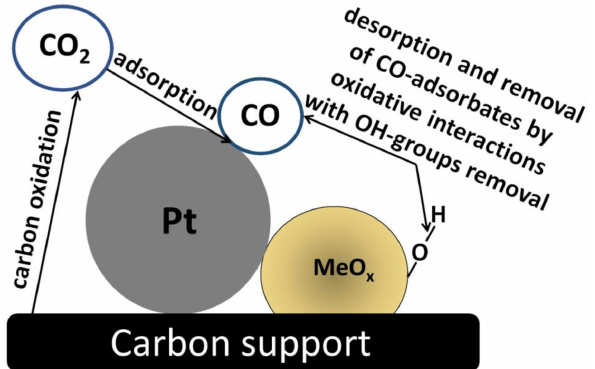
Figure 5. Cartoon illustrating interactions of hydroxyl groups on the metal oxide, MeOx (e.g., ZrO 2 , CeOx, and TiO 2 ) with CO adsorbates existing on platinum (as a result of the oxidation/corrosion of carbon supports) leading to the removal of CO-poisoning